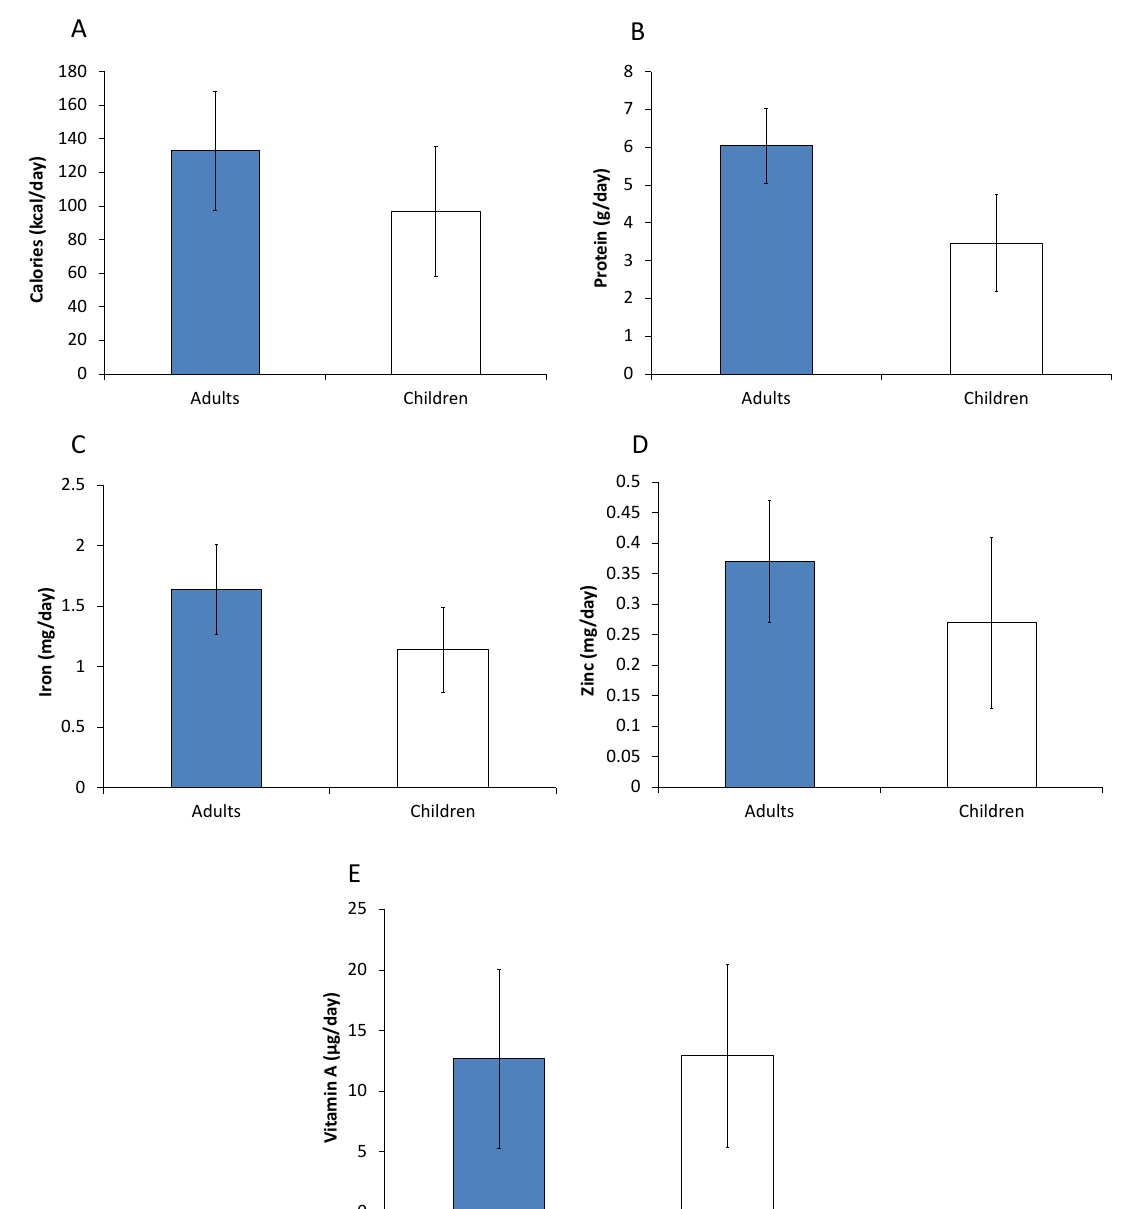
Figure 3. Effects of using modern retailers on calorie and nutrient intakes . Effects of a 10 percentage point increase in the household food expenditure share spent in modern retailers are shown with standard errors bars. Effects were estimated with control function regression models, controlling for income, education, age, and other relevant factors. Models for adults were estimated with 930 individual observations. Models for children were estimated with 499 individual observations. Full model results are shown in Supplementary Tables S14 and S15. ( A ) Effects on calorie intake in kcal/day. ( B ) Effects on protein intake in g/day. ( C ) Effects on iron intake in mg/day. ( D ) Effects on zinc intakes in mg/day. ( E ) Effects on vitamin A intakes in µg of retinol equivalents per day .